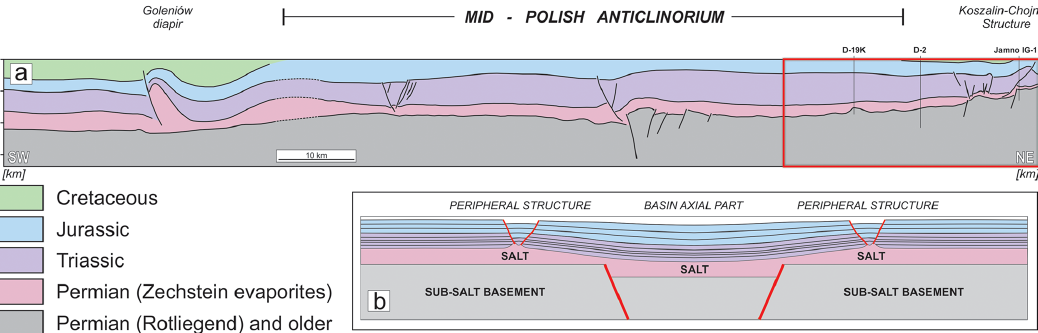
Figure 6. (a) Regional seismo-geological transect illustrating structure of the Mid-Polish Anticlinorium (swell) in NW Poland (cf. Krzywiec, 2006a; Krzywiec et al., 2006). Red rectangle: part of the regional transect that was used to construct balanced model shown in Fig. 8. (b) Schematic model of a decoupled sedimentary basin developed above a thick salt layer during thick-skinned sub-salt extension (modified after Withjack and Callaway, 2000; see also Krzywiec, 2006b, 2012). Peripheral structures developed within the supra-salt sedimentary cover during decoupled extension often focus thin-skinned compressional deformation during ensuing basin inversion (cf. Burliga et al., 2012; Krzywiec, 2002a,